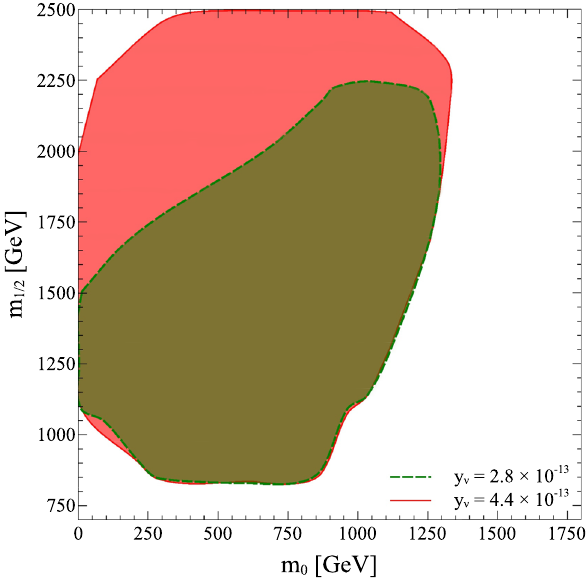
Fig. 10 Allowed parameter region in the m 0 − m 1 / 2 plane satisfying existing collider, low energy, relic and BBN constraints for the ‘hierar- chical’ (green) and degenerate (red) neutrino masses. Here, m 0 , 1 / 2 < 2500 GeV, | A 0 | < 3000 GeV, 5 < tan β < 40, 0 < m ˜ ν sign (μ) >